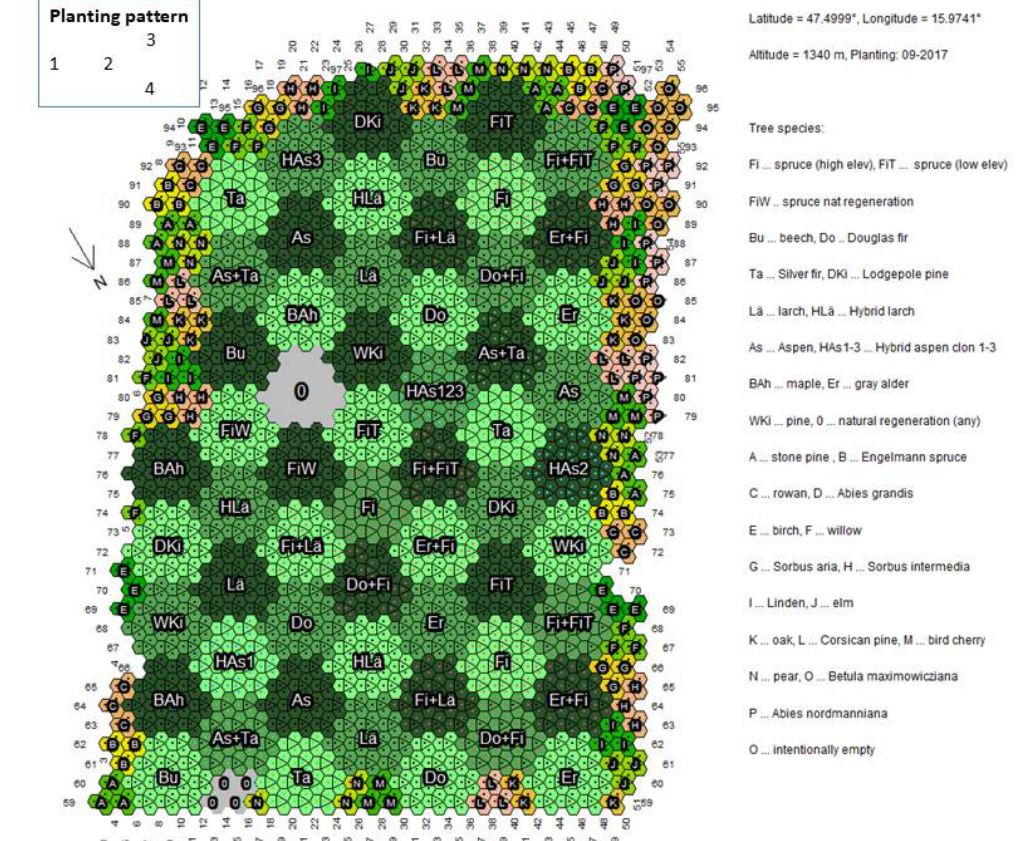
Figure 2. The space-saving experimental design minimizes the edge effect and allows for the maximum number of plots in a given area. The letters represent the tree species combinations on each plot. The arrangement of tree seedlings in one individual cell is shown in the upper-left